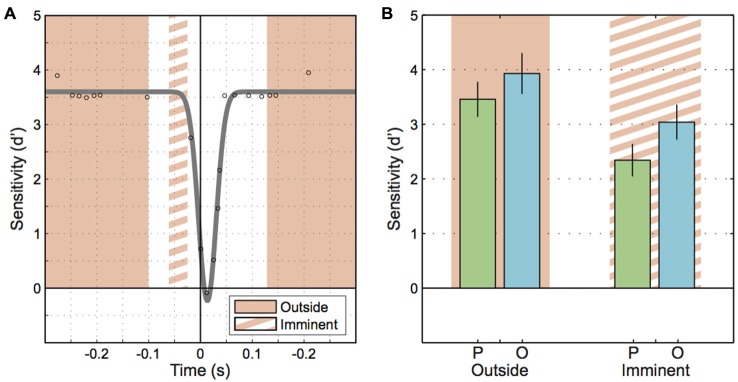
Motion sensitivity when a saccade is imminent. (A) Schematic illustrating the epochs for motion onset that fall outside of the perisaccadic interval (solid orange region) and the epoch where saccades are imminent (orange striped region). (B) Sensitivity to parallel and orthogonal motion probes outside of the perisaccadic interval and when saccades are imminent. Error bars represent the standard error.